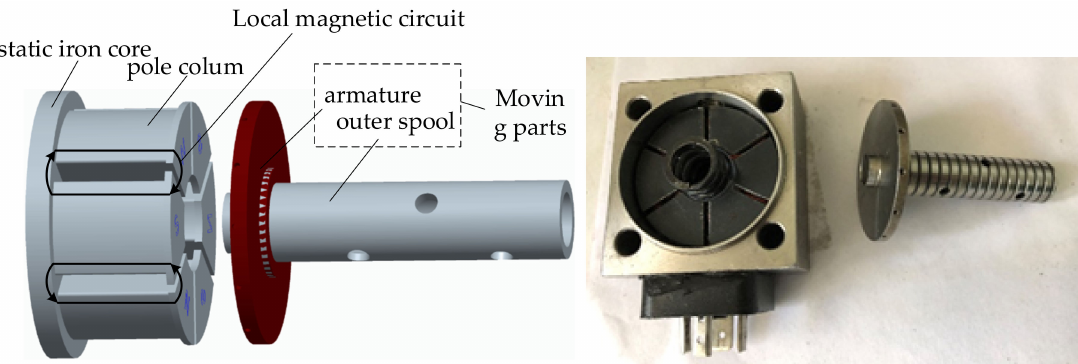
Figure 3. Annular pole electromagnet and moving parts.